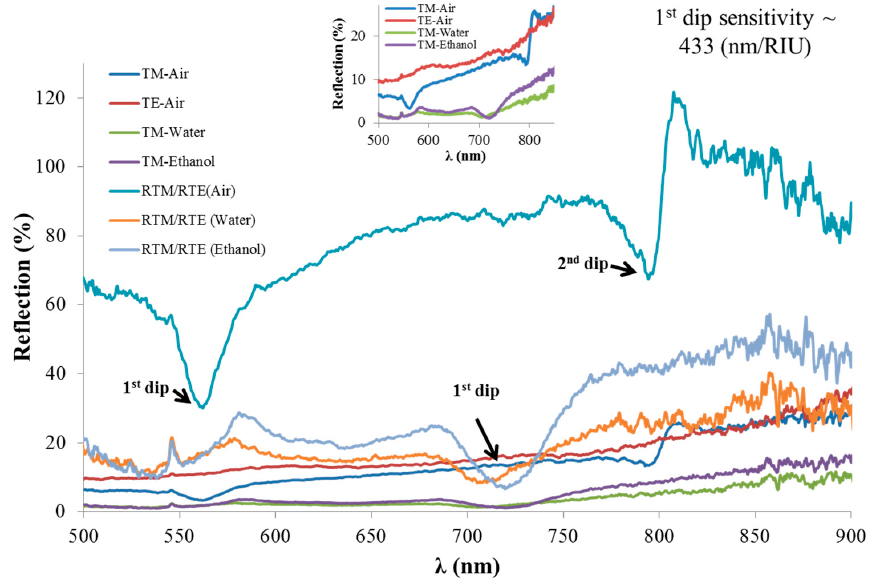
Figure 16. Experimental reflection spectra from the prepared sample extracted from the CD-R at different analytes in the visible range. different analytes in the visible